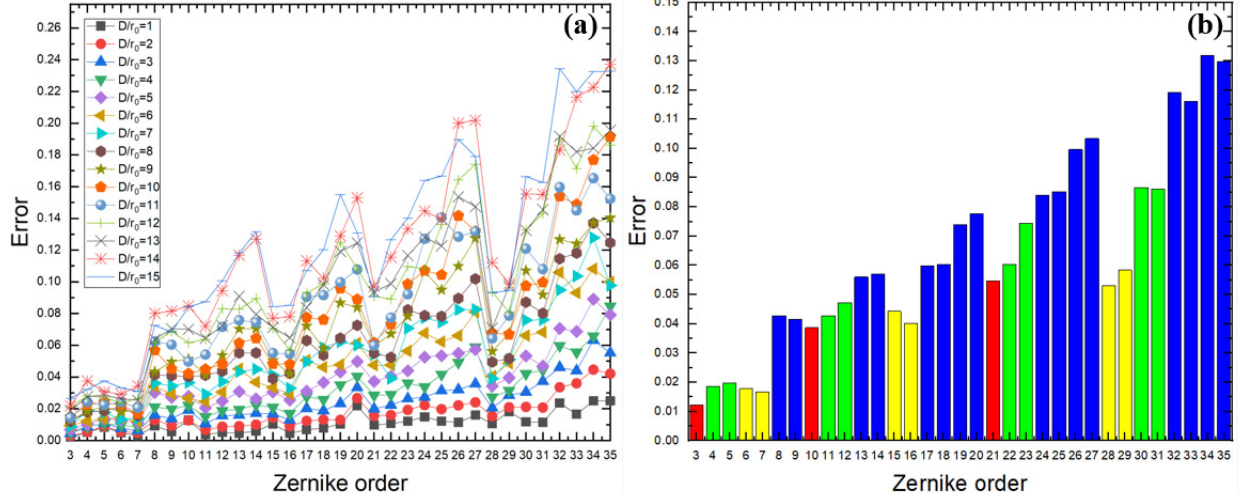
Figure 7. The statistical results of the Zernike coefficient error of each Zernike order: ( a ) in the case of different turbulence intensities, the error is counted as a broken line graph; ( b ) in the case of different turbulence intensities, the error is counted as a bar.